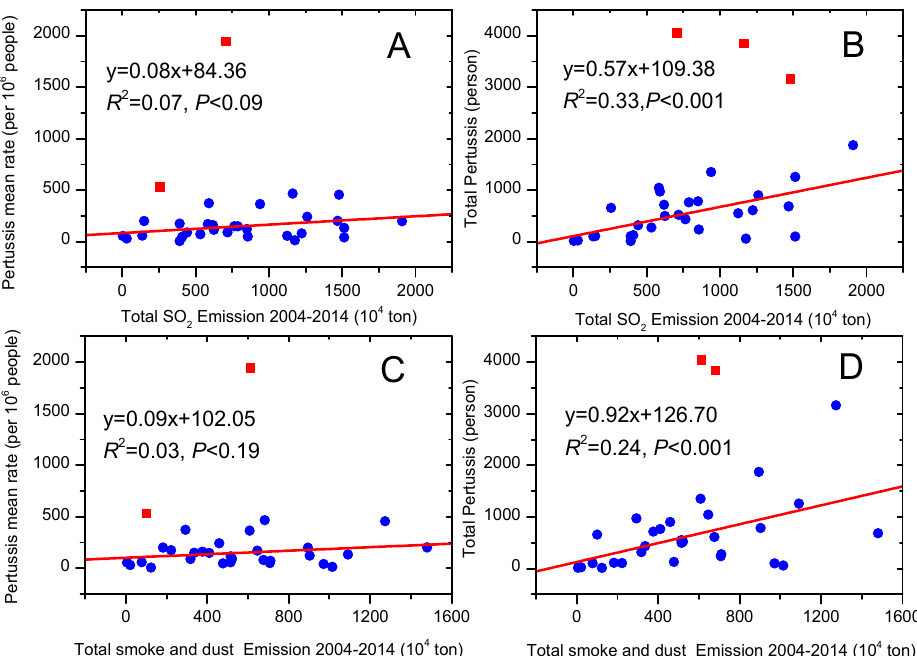
Figure 5. The relationships of pertussis mean rate and total pertussis, with total SO 2 emission ( A , B ); total smoke and dust emission ( C , D ) during 2004–2014 at provincial level. Note that the red blocks are excluded from the regressions. Data resources: China Statistical Yearbook (2004–2015) [9] and China Statistical Yearbook of Health and Family Planning (2004–2015) [11].